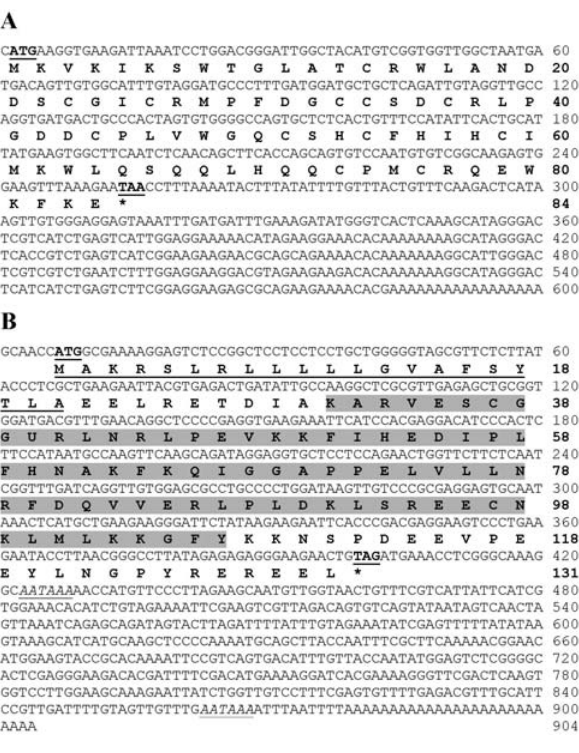
Figure 2 - The full length cDNA and deduced protein sequences of PmAPC11 (600 bp, ORF of 255 bp corresponding to a deduced poly- peptide of 84 amino acids; GenBank accession no. GW775392) and PmSePM (904 bp, ORF of 396 bp corresponding to a deduced polypeptide of 131 amino acids; GenBank accession no. GW775333). The putative start and stop codons are illustrated in boldface and underlined. The pre- dicted signal peptide and poly A additional signals of PmSePM are under- lined and italicized and underlined, respectively. The predicted Sep15_SelM domain (positions 31-107) found in the deduced PmSePM protein is